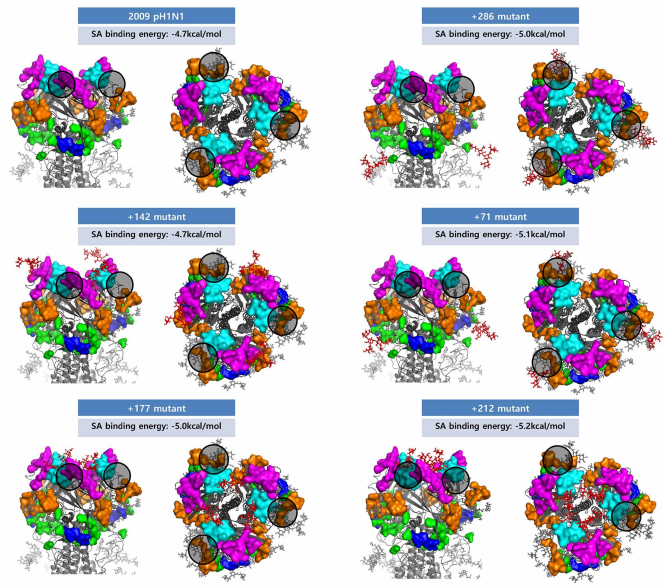
Figure 8. Glycosylated H1 trimer structures and sialic acid binding affinities. The H1 antigenic sites Ca, Cb, Sa, Sb, and H1C are shown in orange, blue, magenta, cyan, and green, respectively. The glycans newly introduced by mutations are marked in red. The predicted sialic acid binding affinities are shown, and the binding sites are represented with black circles. The 142, 177, and 212 glycosylations are located on top of the HA head domain, whereas the 286 and 71 glycosylations are on the side of the domain. The structures are represented as viewed from the side ( left ) and top ( right